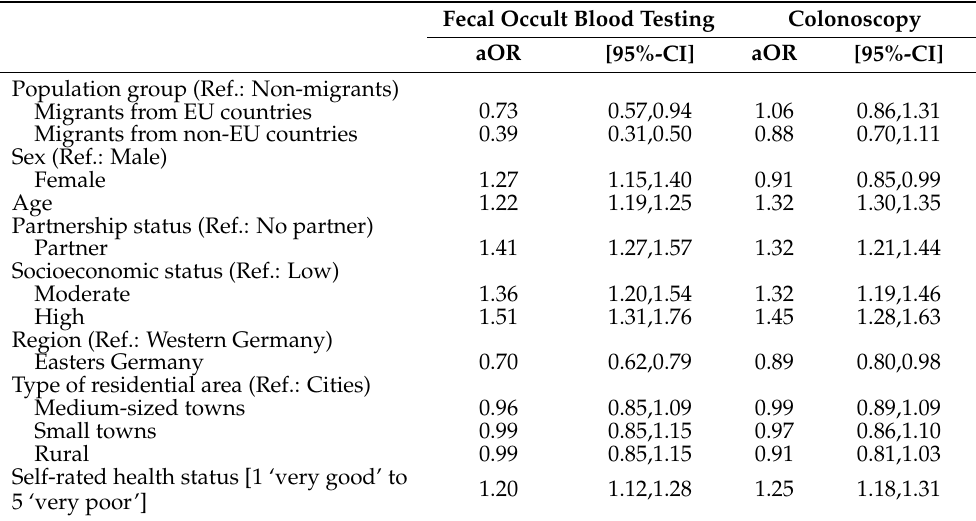
* p -value from chi-square test for categorical variables and analysis of variance for continuous variables. Table 2. Results of the multivariable logistic regression model with utilization of fecal occult blood testing and colonoscopy, respectively, as the dependent variables. Adjusted odds ratios (aOR) and 95% confidence intervals (95%-CI) (German Health Update 2014/2015, respondents aged ≥ 50 years, n =